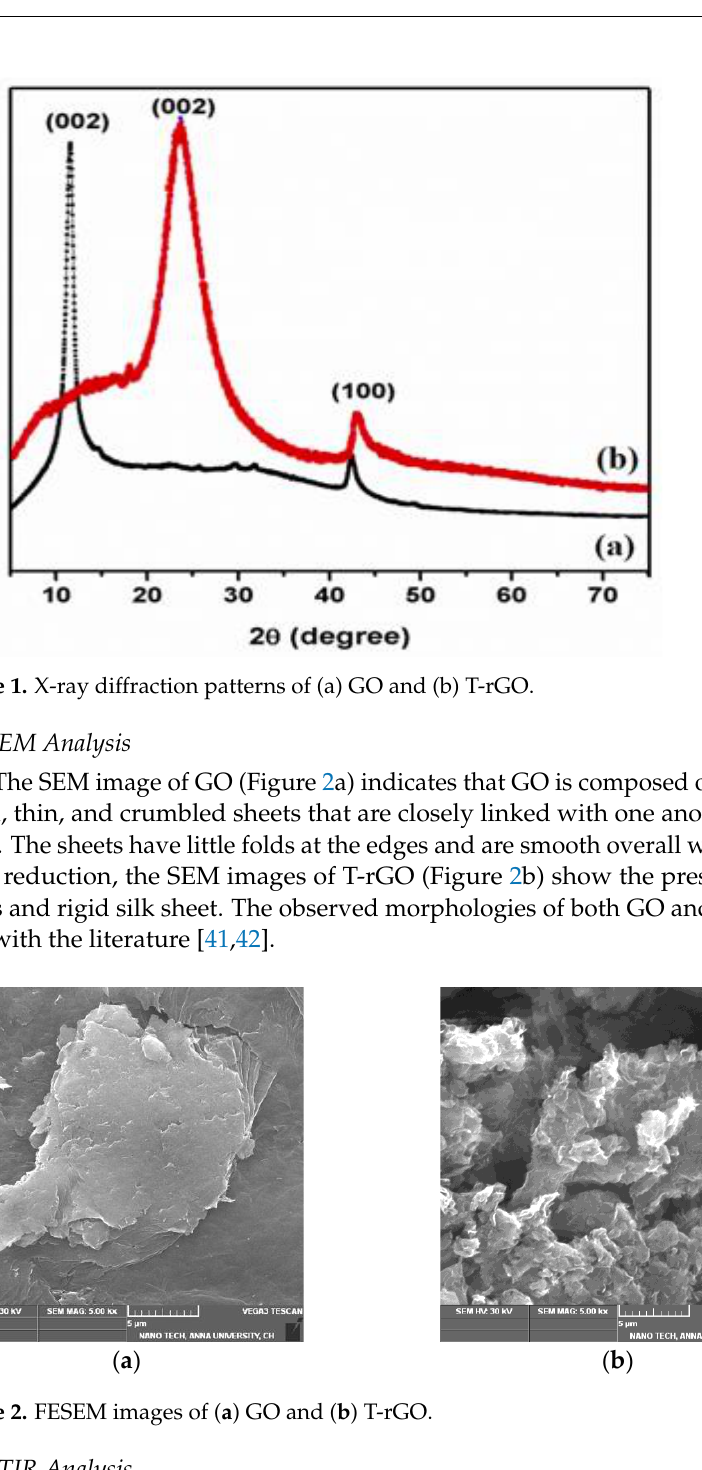
Figure 2. FESEM images of ( a ) GO and ( b ) T-rGO.